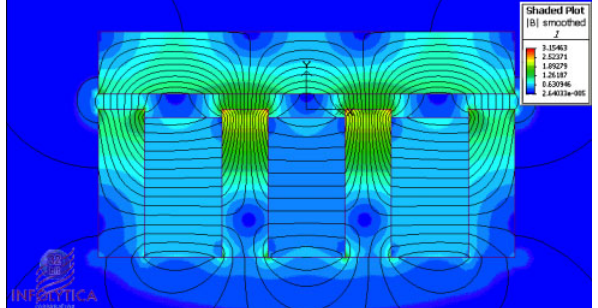
Figure 15 The magnetic flux and flux density.